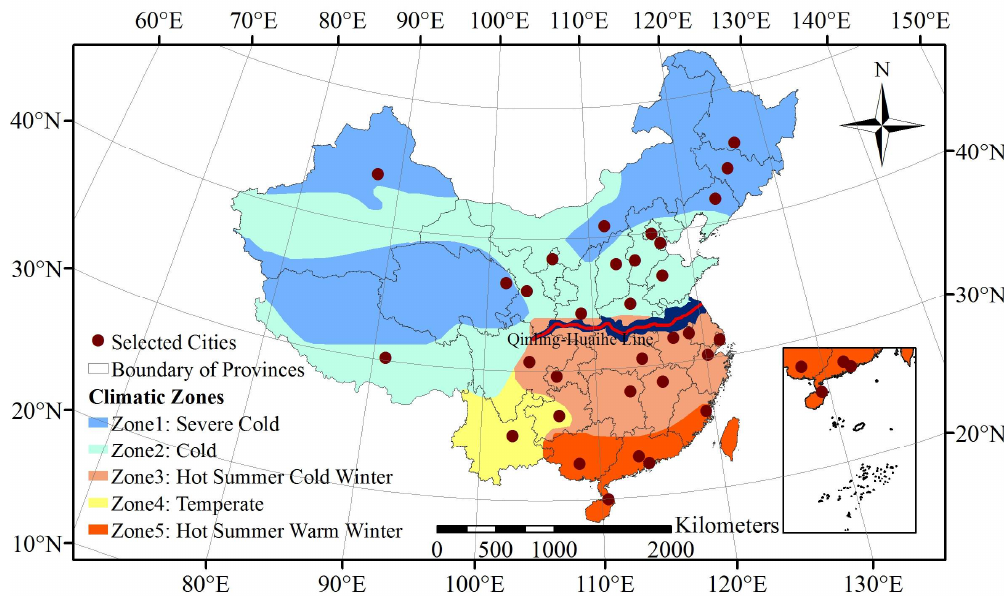
Figure 1. The study area and the distribution of selected cities in this research.